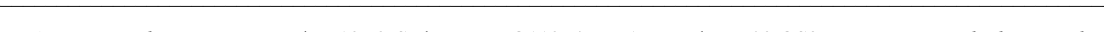
Fig. 5. A , Drepanodus arcuatus Pander, 1856, S element, LO11354t, × 51, sample Est09:OS2. B (cid:150) D , Microzarkodina